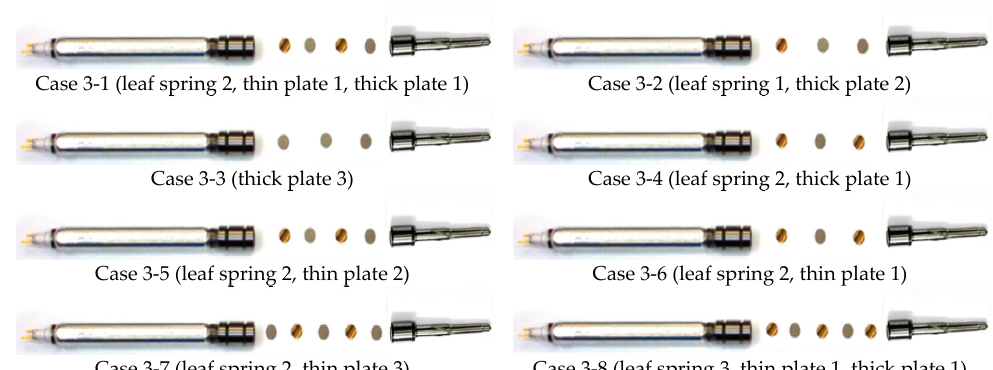
Figure 11. Detailed designs of Type 3 DPIs.